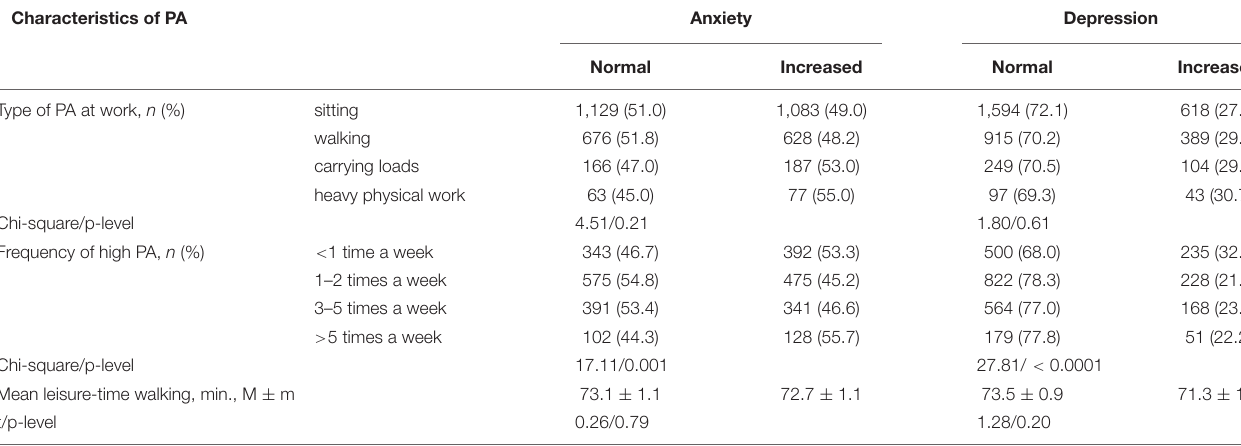
TABLE 4 | Physical activity (PA), anxiety and depression. Characteristics of PA Anxiety Depression Normal Normal